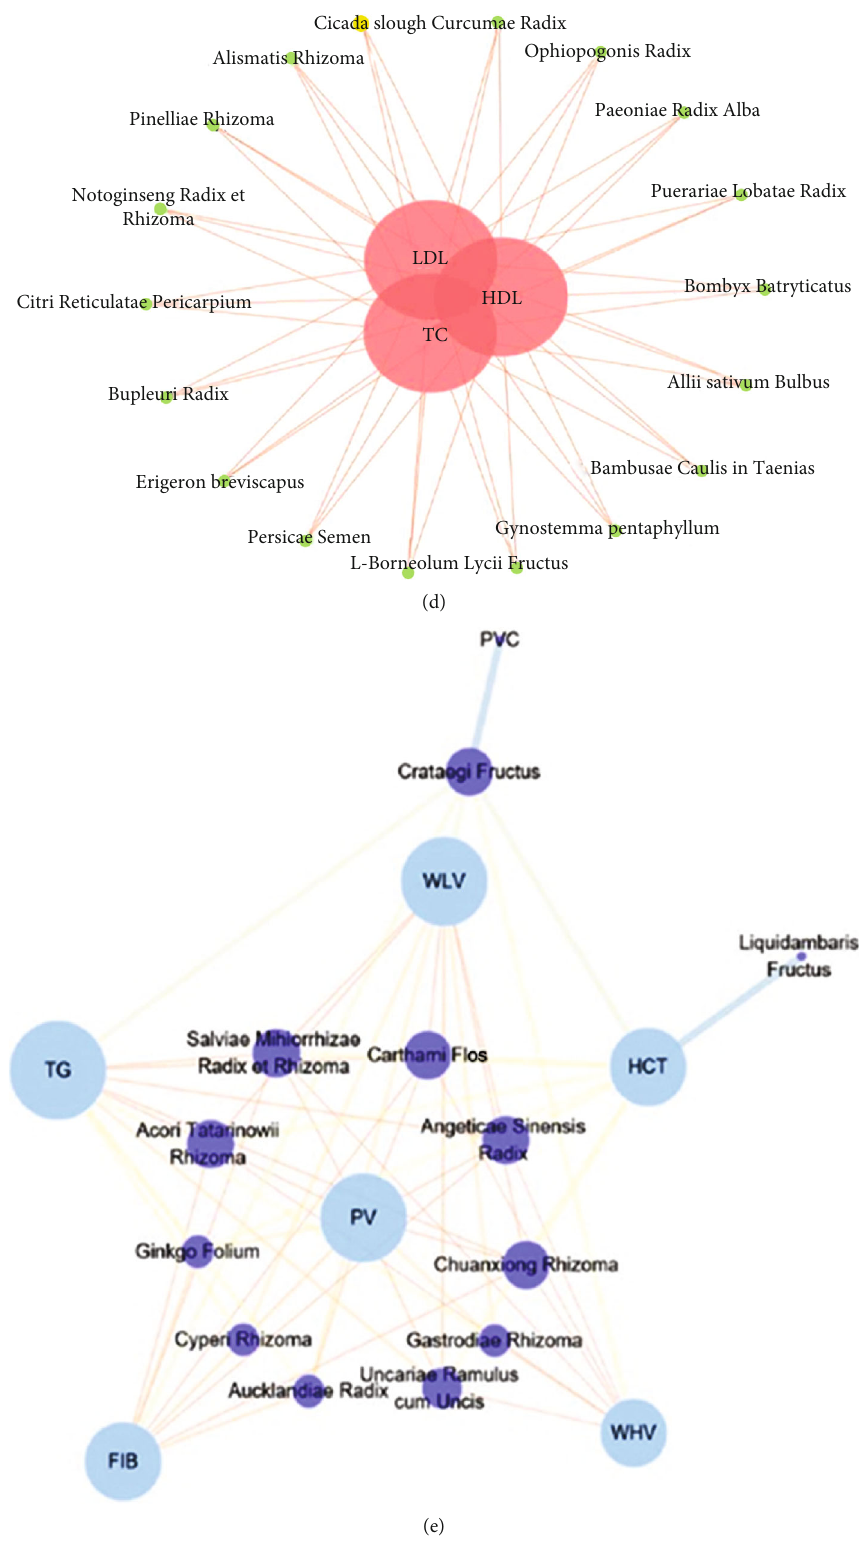
Figure 10: Analysis diagram of TCM-index network